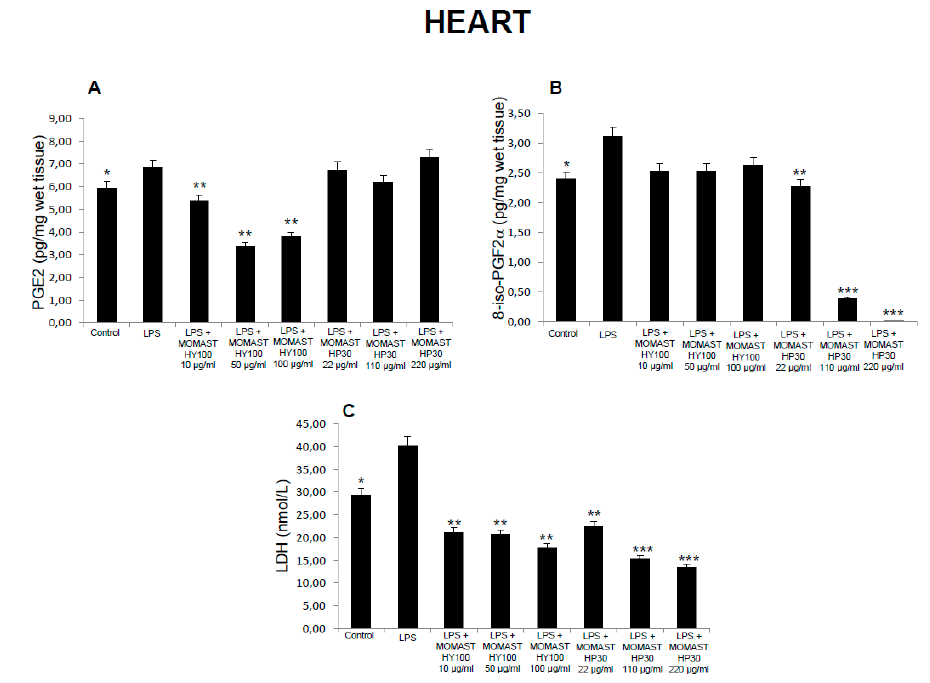
Figure 4. Effects of MOMAST( ® ) HY100 (10, 50, and 100 µg/mL) and MOMAST( ® ) HP30 (22, 110, and 220 µg/mL) on ( A ) PGE 2 levels (pg/mg wet tissue), ( B ) 8-iso-prostaglandin F 2 α (8-iso-PGF 2 α ) levels, and ( C ) lactate dehydrogenase (LDH) activity (nmol/L) in rat heart specimens. Data were reported as means ± SEM. ANOVA, p < 0.01; post-hoc test, * p < 0.05, ** p < 0.01, *** p < 0.001 vs. LPS-treated group.